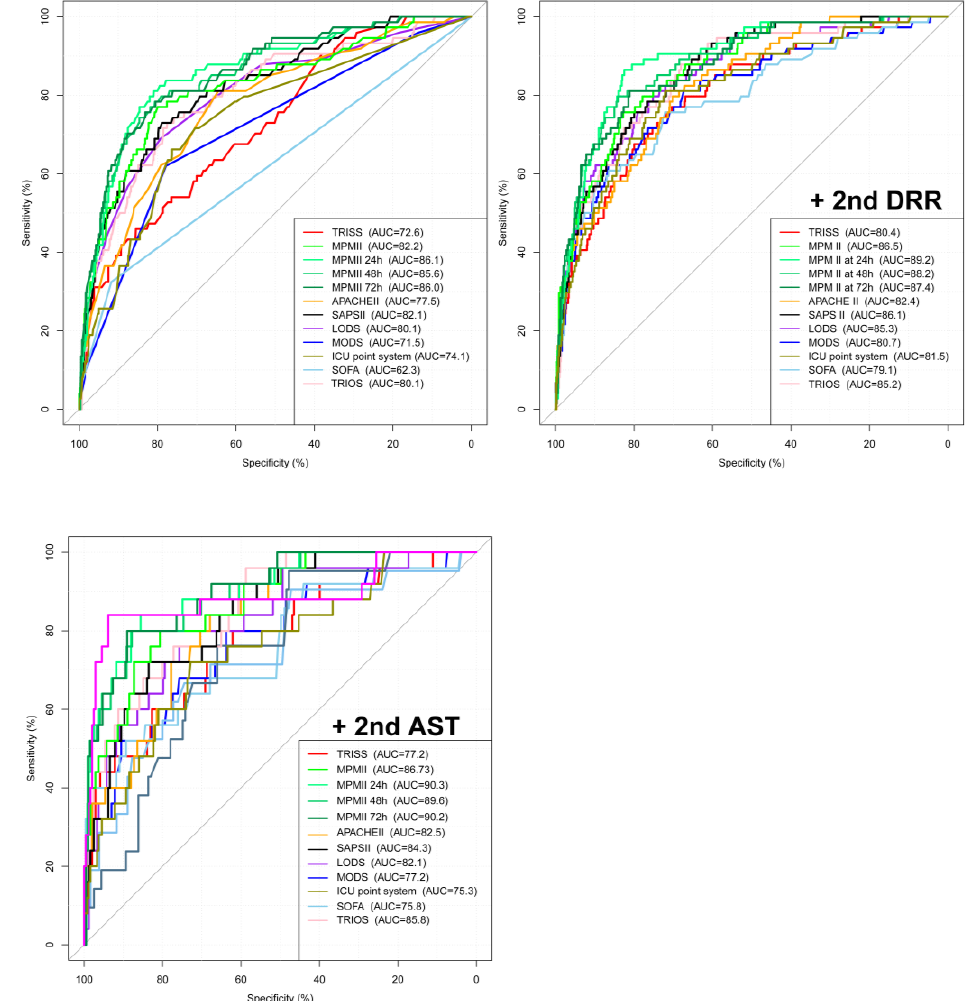
Figure 3. The receiver operating characteristic curves and the area under the curve (AUCROC) of the prognosis prediction models in predicting mortality (left above figure) and those curves with inclusion of the 2nd DRR (right above figure) or 2nd AST (left lower figure) as an additional variable in the mortality outcome prediction.